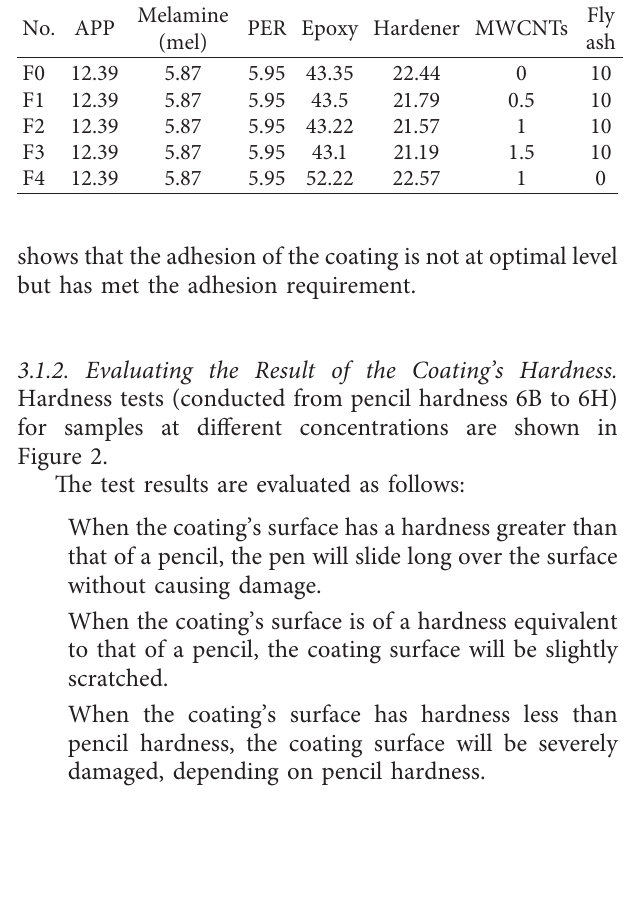
Table 3: Weight percentage of the